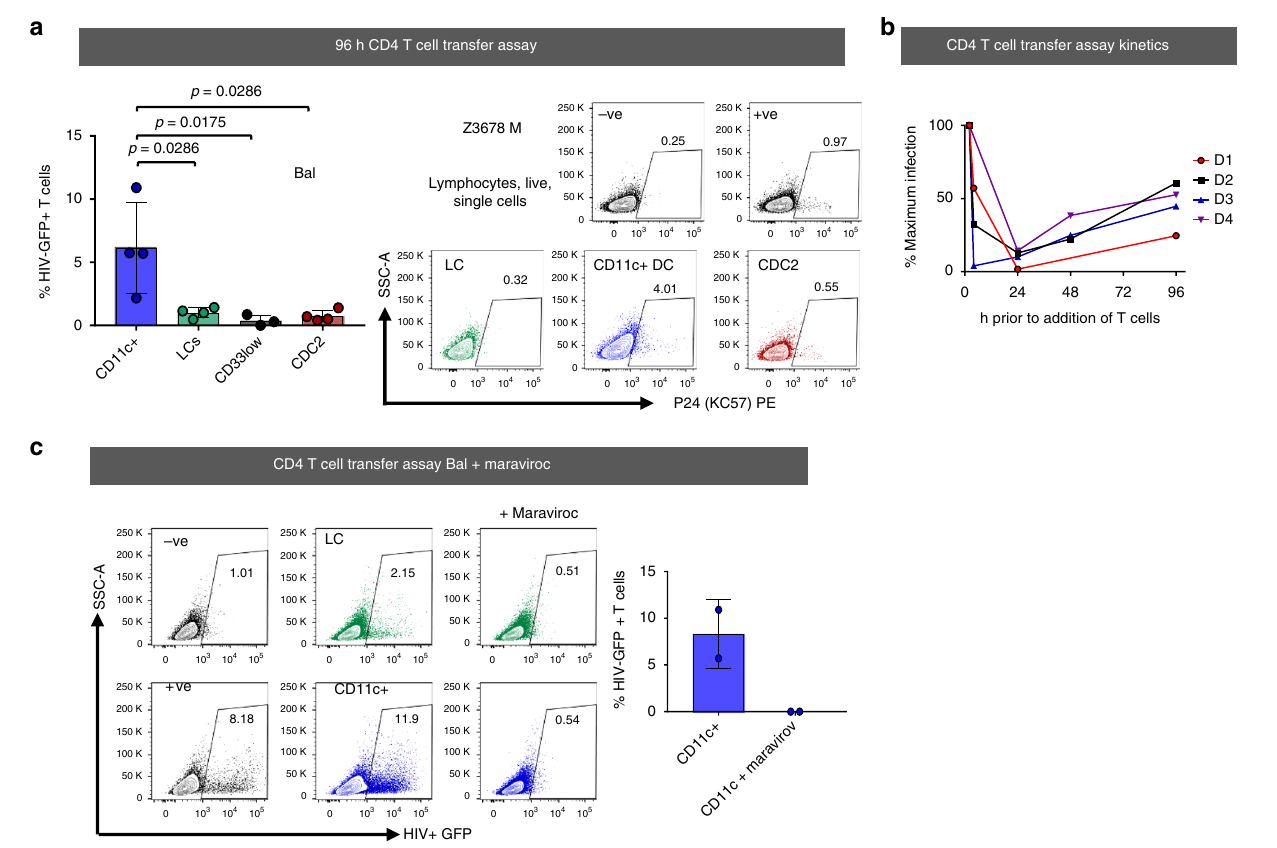
Fig. 8 HIV transfer capacity of epidermal mononuclear phagocytes. Epidermal MNPs were either infected as sorted subsets and treated with HIV BaL , HIV Z3678M , or mock treated for 2 h, after which the virus was thoroughly washed off and cultured in human skin fi broblast conditioned media. a JLTR cells were added to MNP subsets infected with HIV BaL , for 96 h at a ratio of 4 JLTR: 1 DC and co-cultured for a further 96 and the number of infected T cells was determined by fl ow cytometry. Transfer of HIV BaL , to T cells was assessed. The % of GFP + JLTR cells cultured with each epidermal MNP subset was plotted as the mean ± standard deviation, with each dot representing an individual donor. (CD11c + = 4, LCs = 4, CD33 low = 3, CDC2 = 4). Transfer of HIV Z3678M , to T cells was assessed. Primary activated CD4 T cells derived from PBMCs were added and to MNP subsets infected with HIV Z3678M , for 96 h at a ratio of 2 T cells:1 DC and co-cultured for a further 72 h and the number of infected T cells was determined by staining for live/dead and HIV P24 + and analysing by fl ow cytometry. Representative fl ow plots of p24 + primary T cells after transfer are shown. b JLTR cells were added to sorted CD11c + DCs infected with HIV BaL , for 2, 4, 24, 48 and 72 h and co-cultured for a further 96 h and the number of infected T cells was determined by fl ow cytometry. Infection at 2 h was set at the maximum infection for each donor and time points plotted as a % of maximum infection. c Sorted MNP subsets were pre- treated for 1 h with 10 µ M maraviroc. After a 2 h infection, cells were washed three times and incubated in the presence of maraviroc. At 96 h, maraviroc was washed off and JLTRs were added then co-cultured for a further 96 h and the number of infected T cells was determined by fl ow